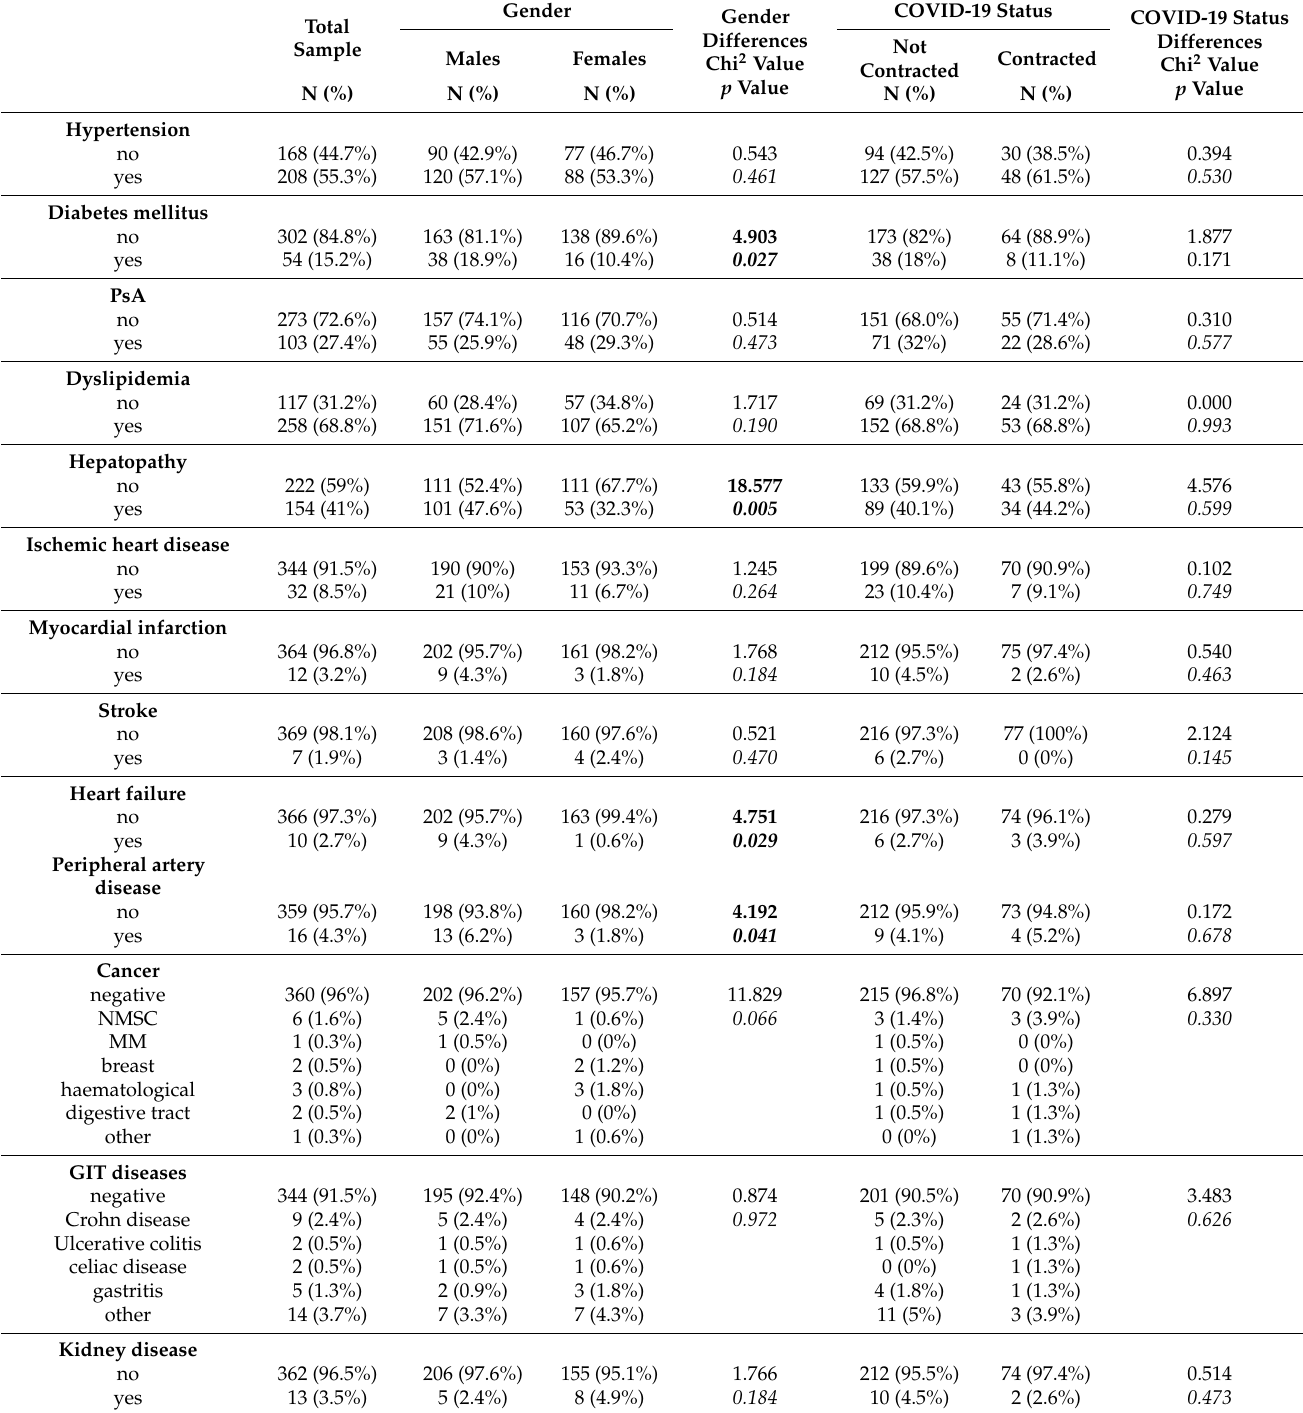
Table 4. Summarisation of major comorbidities of psoriatic patients (numbers and relative prevalence in %) presented for the total sample and stratified according to gender and COVID-19 contraction status, differences tested with Pearson’s chi-squared